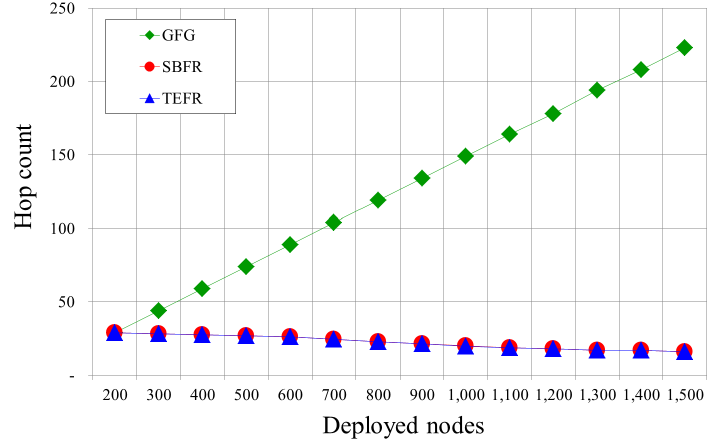
Figure 13. Hop counts according to the number of deployed nodes (radio range: 100